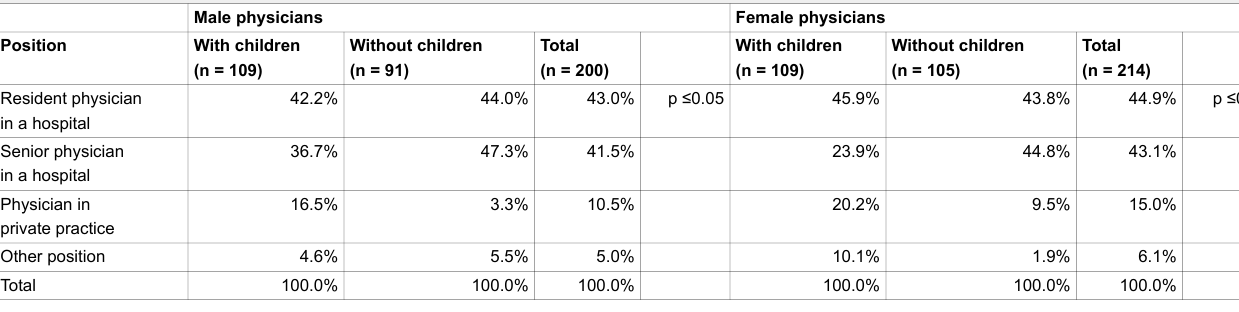
Table 1: Occupational position of male and female physicians with and without children (N = 414). Male physicians